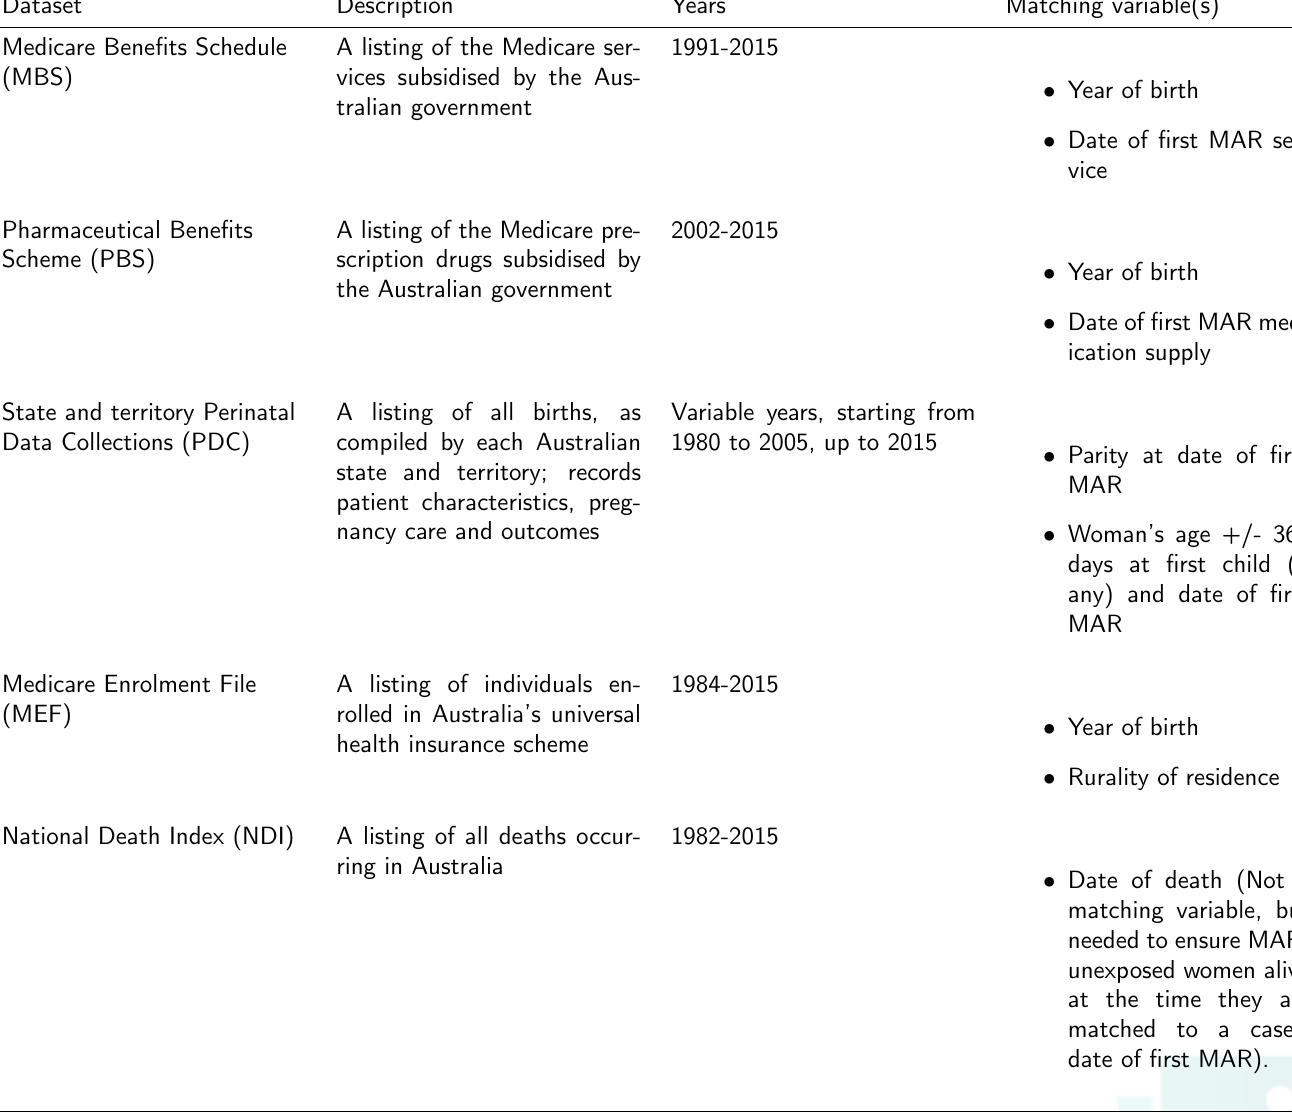
Table 1: Datasets and key variables used to match and account for parity and other potential confounders at the date of first exposure to medically assisted reproduction